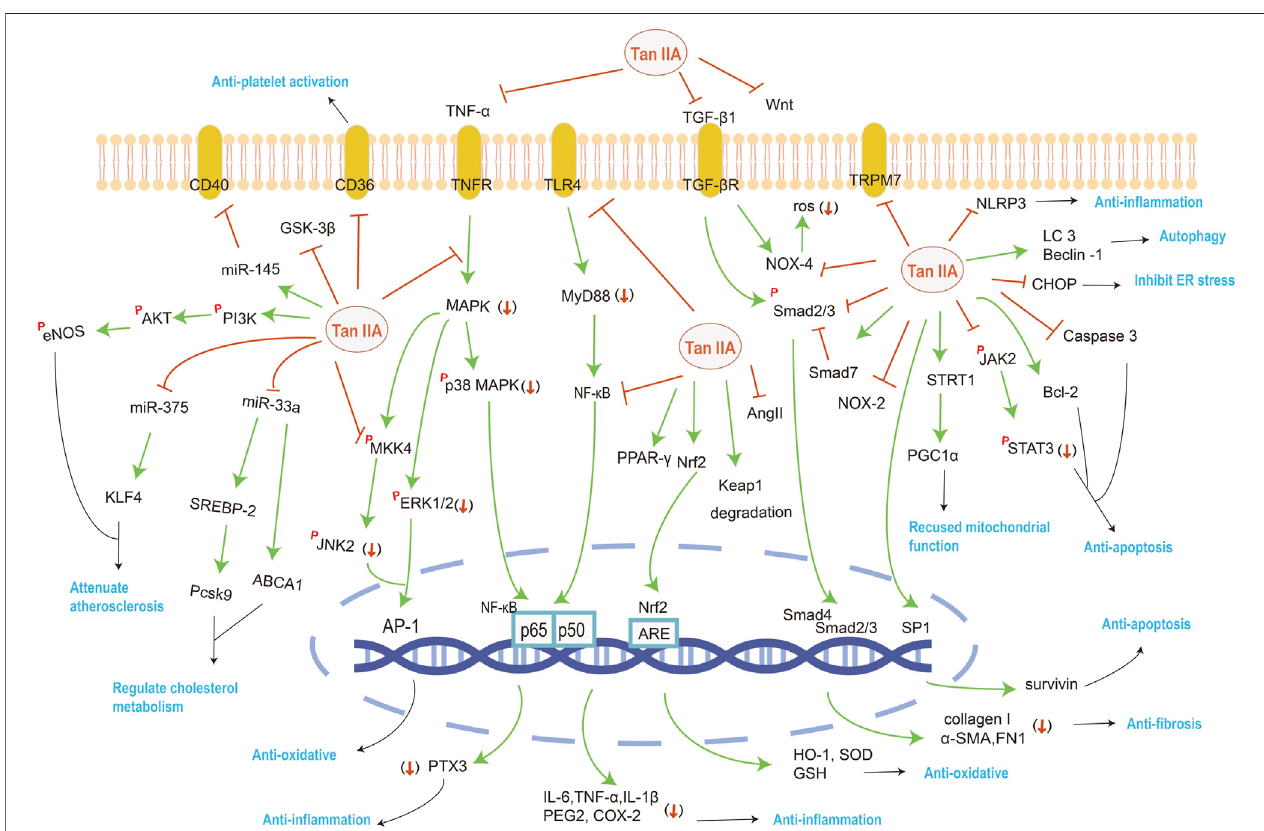
FIGURE2| ThemainlyaffectedtargetsandpathwaysbyTanIIAagainstvarioussystemdisorders.Theorangeredsymbols( ↓ ), ┤ and p representdown-regulation, inhibition and phosphorylation of proteins respectively, and green line-arrow “ → ” means singal transduction.